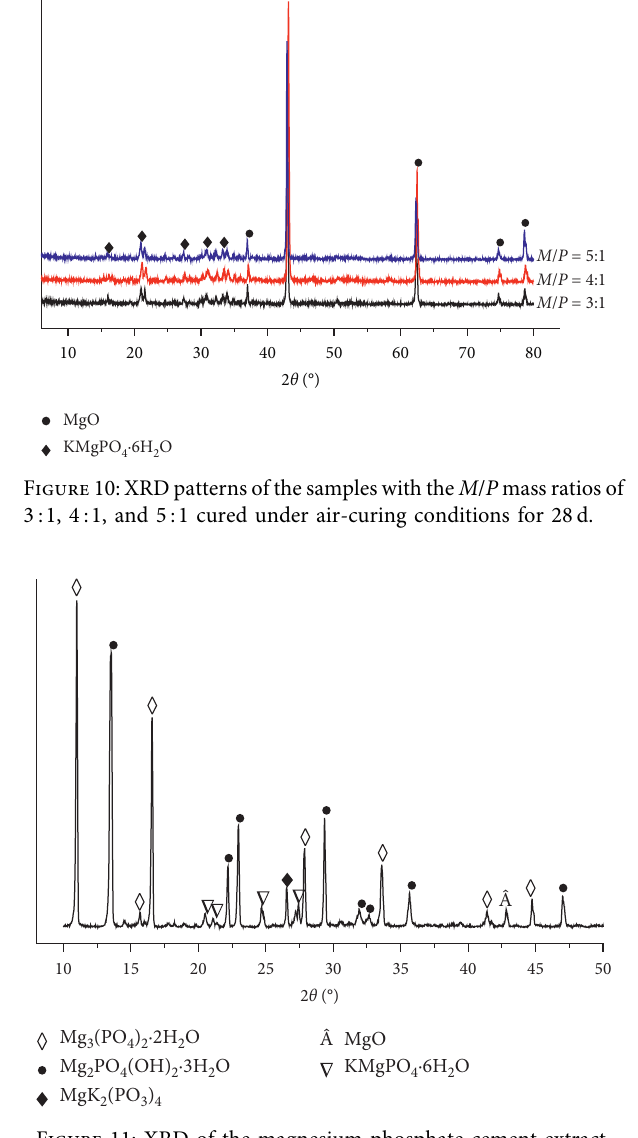
Figure 11: XRD of the magnesium phosphate cement